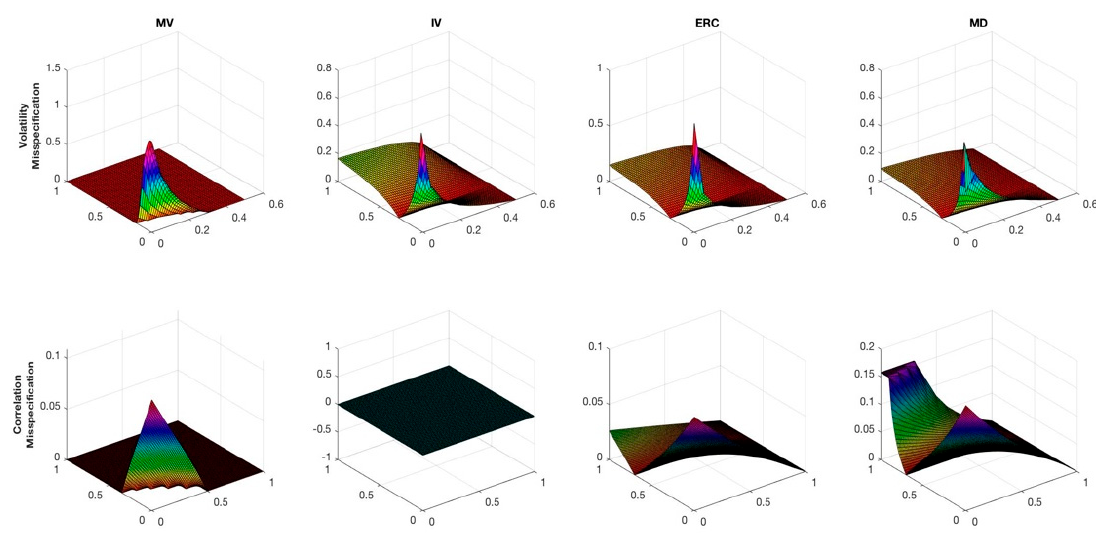
Figure 1. Frobenius norm between true and estimated weights; first row reports misspecification in volatility, while second row in correlation. The surfaces’ three dimensions are: the shrinkage intensity in y axis (from 0 to 1); the misspecification in the volatility (from 0 to 0.5) or in the correlation (from 0 to 1) in x axis and the Frobenius norm in z axis. Each column refers to a specific risk-based portfolio. From the left to the right: Minimum Variance (MV), Inverse Volatility (IV), Equal-Risk-Contribution (ERC), Maximum Diversification (MD), respectively.